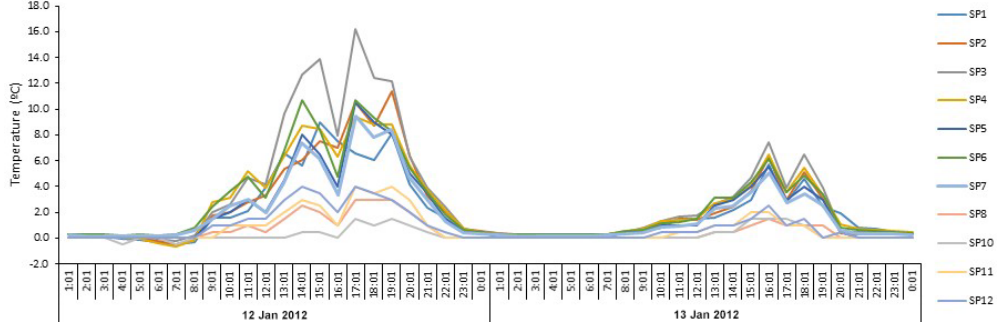
Figure 7. Snow-patch temperatures measured at 5cm depth from 12 to 13 January 2012. The peaks in the maxima relate to anomalous overheating of the minilogger case. SP1–SP12 are the snow-patch numbers. SP13 was not monitored.